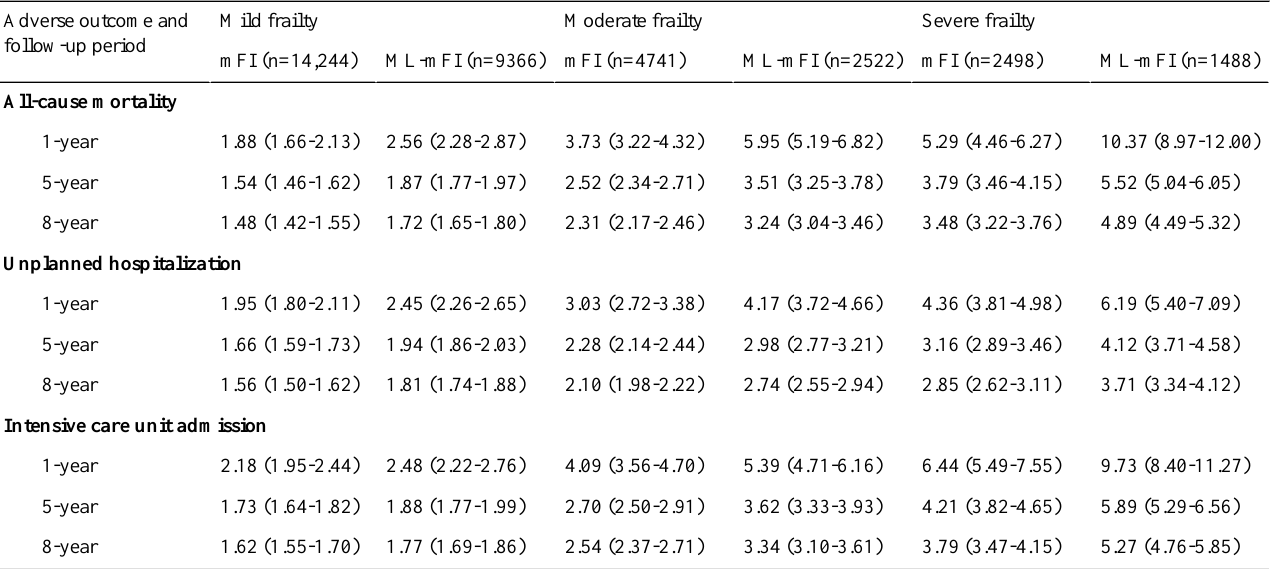
Severe frailtyModerate frailtyMild frailtyAdverse outcome and